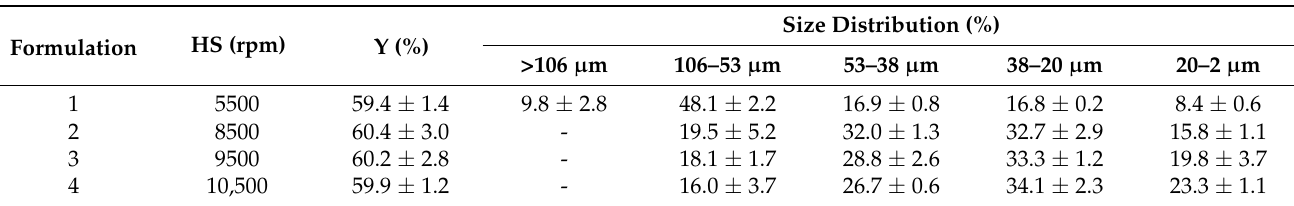
Table 2. Production yield (Y) and particle size distribution of formulations elaborated at different homogenization speeds (HS) ( n = 3).